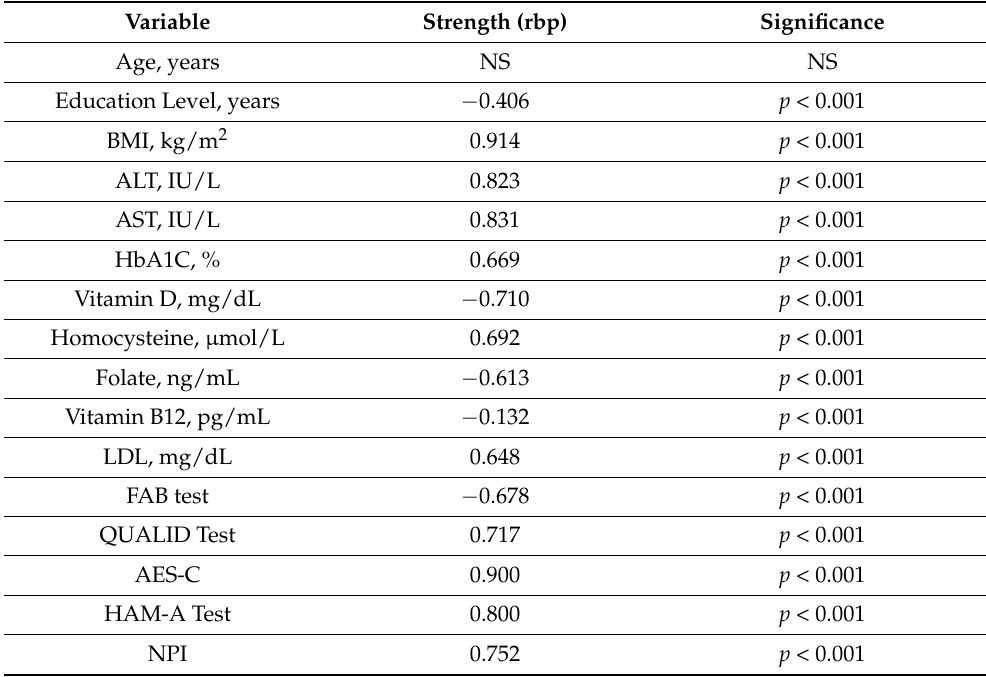
Table 3. Correlations between NAFLD severity and the measured variables investigated through point-biserial correlation